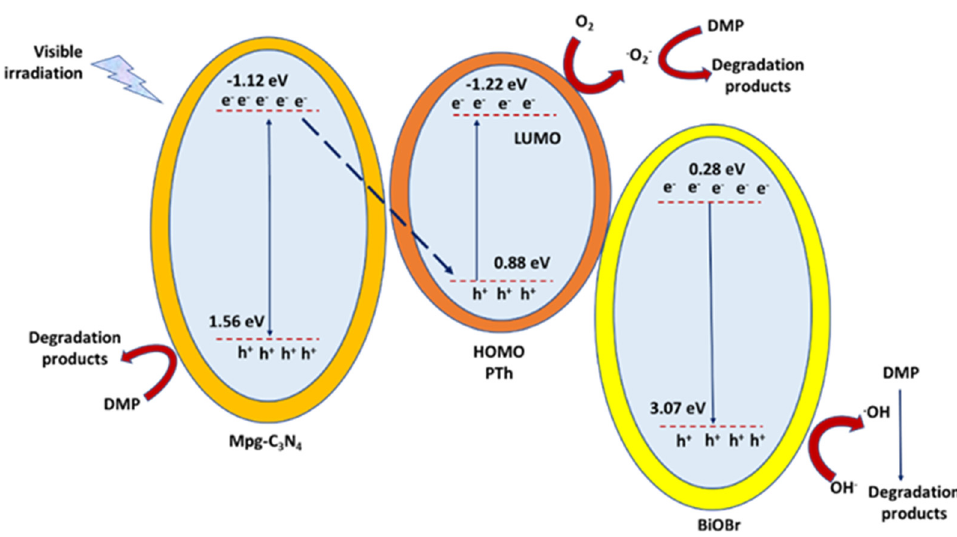
Figure 8. The schematic mechanism for DMP photocatalytic degradation over mpg-C 3 N 4 /BiOBr/PTh (polythiophene) heterostructure under visible-light irradiation, as described into [89]. Studies on non-irradiated removal of PAEs relied mainly on sulfate-mediated pro- cesses. Dong et al. [90] performed the degradation of several phthalates in marine sediments by sodium persulfate (Na 2 S 2 O 8 , PS) activated by a series of iron–cerium (Fe-Ce) bimetallic catalysts (FCBCs). With a Fe-Ce molar ratio of 1.5:1 the degradation of DMP, DEP, di-2-ethylhexyl phthalate, dioctyl phthalate and diisononyl phthalate showed the